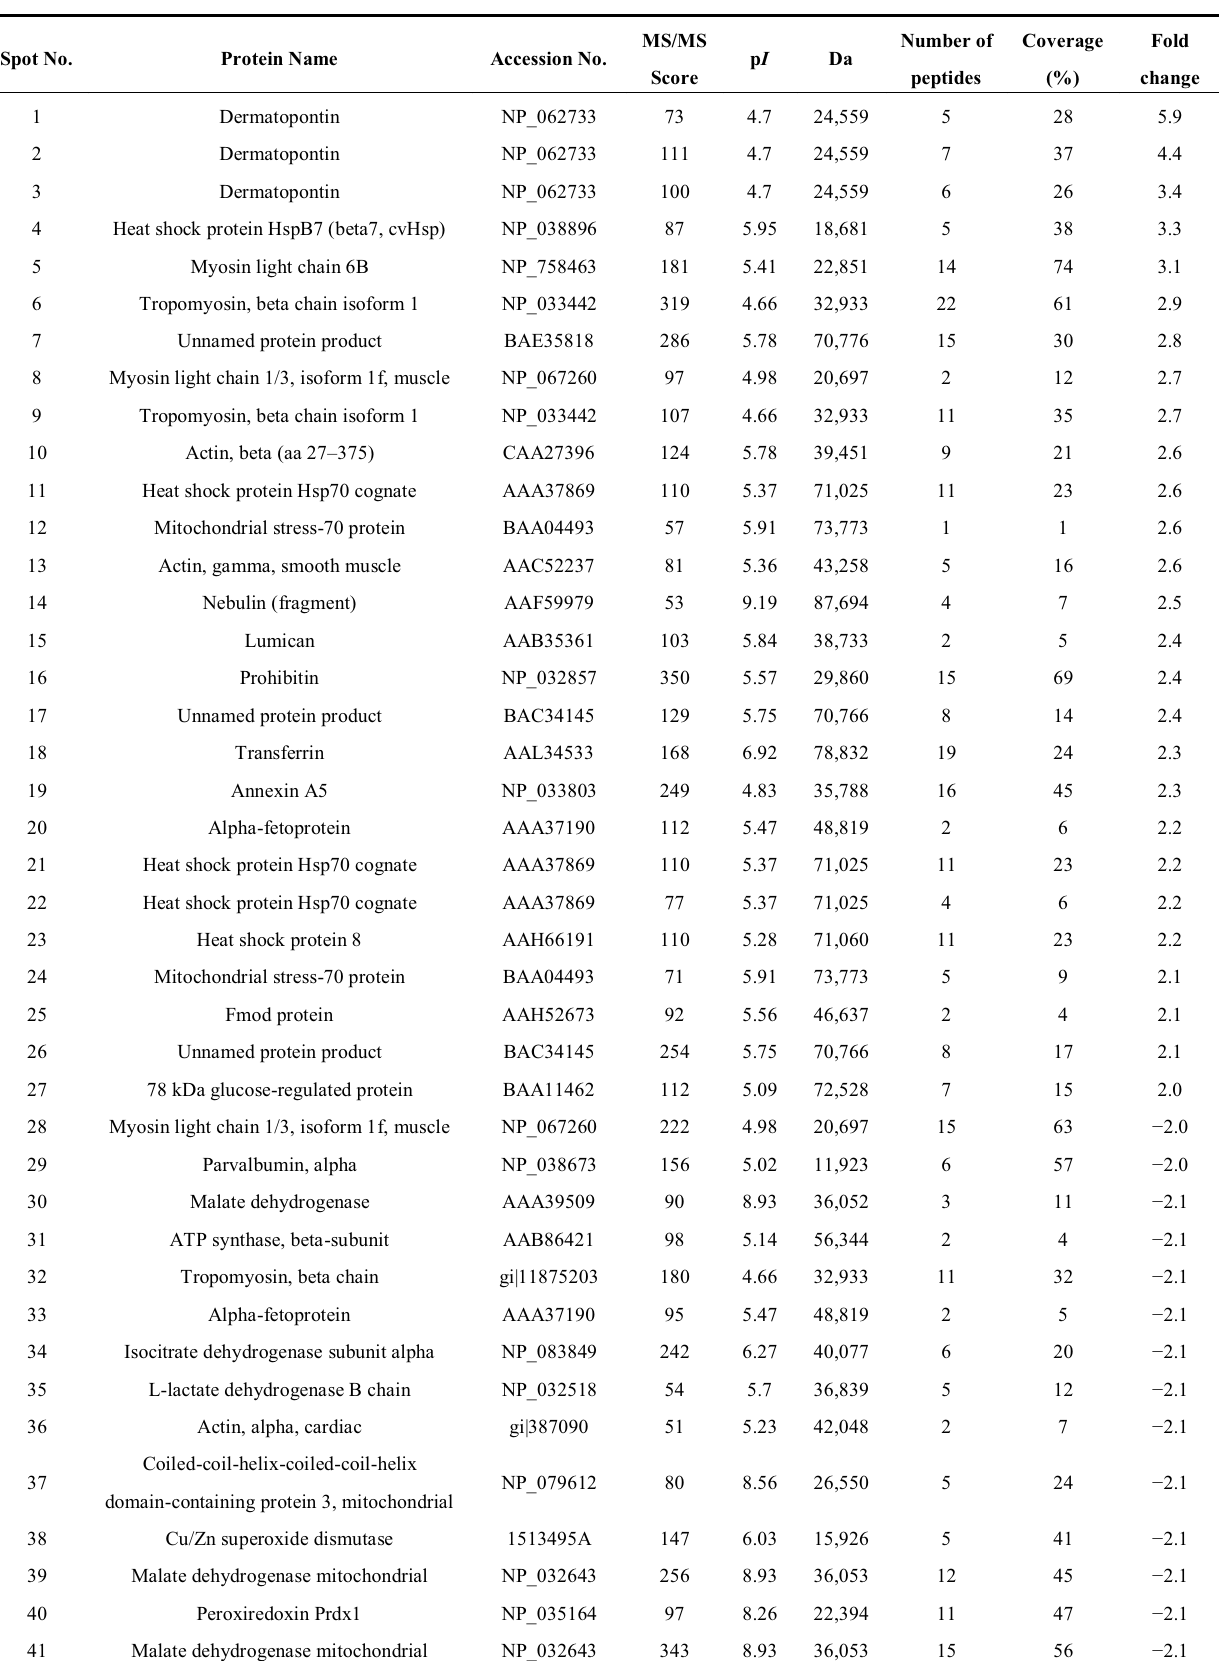
Table 1. List of identified proteins that exhibit a drastic change in abundance in the aged mdx diaphragm as revealed by 2D-DIGE